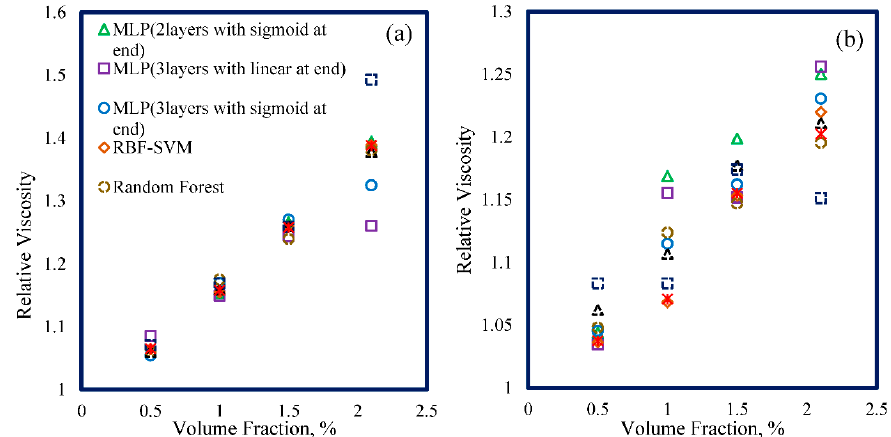
Figure 11. Variation of relative viscosity with a volume fraction of nanoparticles for two nanofluid samples, ( a ) ZnO (48 nm)—EG, ( b ) ZnO (4.6 nm)—EG [73].